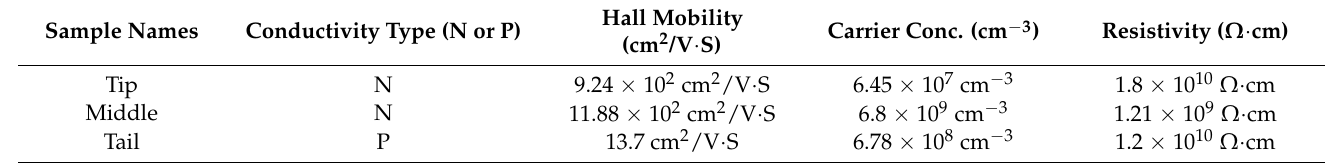
Table 1. Hall and I-V measurement results of Tip, Middle and Tail wafers of co-doped CdZnTe:(In,Pb) crystals. Sample